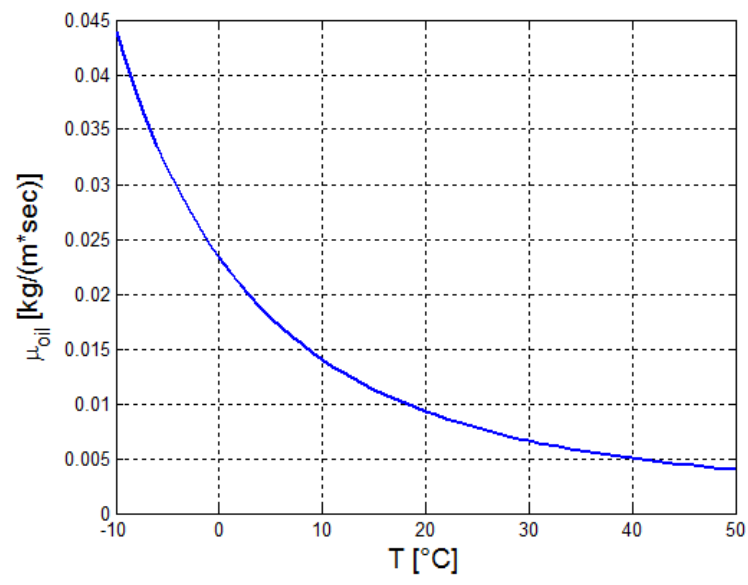
Figure 9. The viscosity of liquid crude oil.